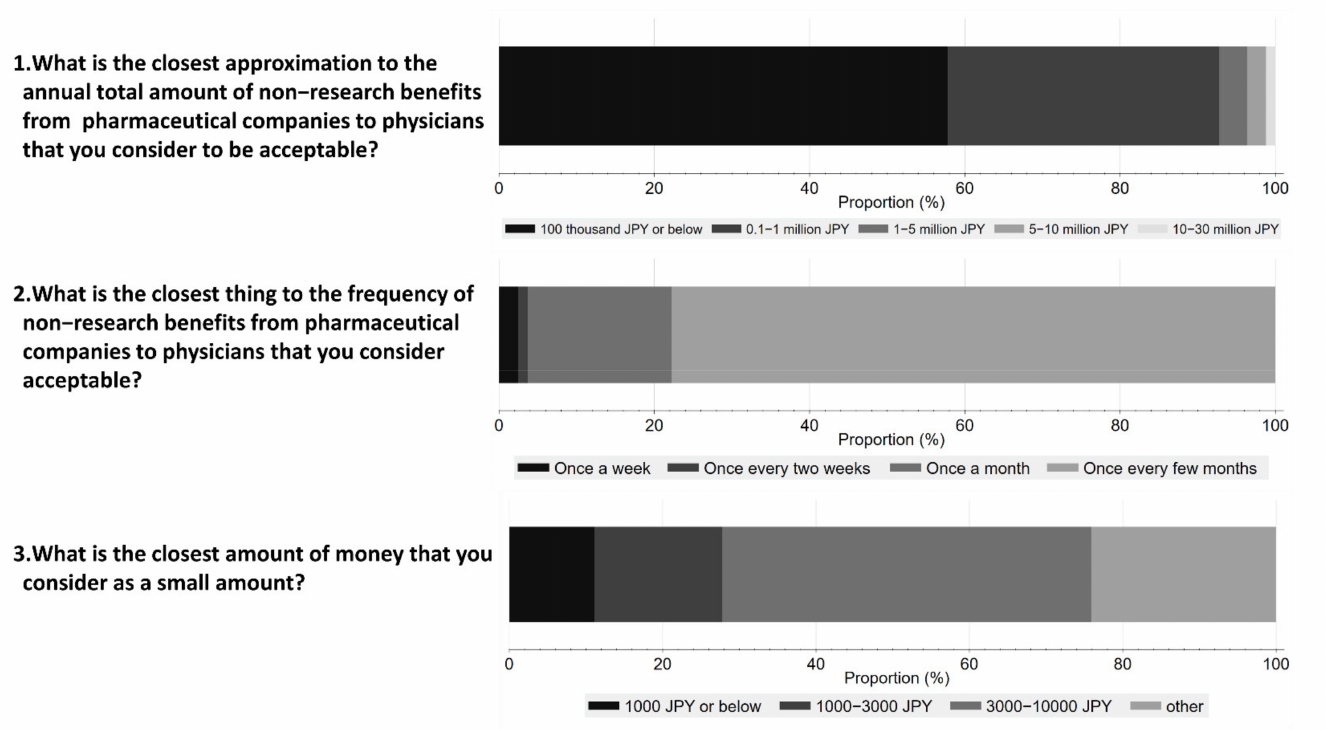
Figure 3. Respondents’ perceptions on statements regarding interactions between physicians and pharmaceutical companies and their associated regulations.